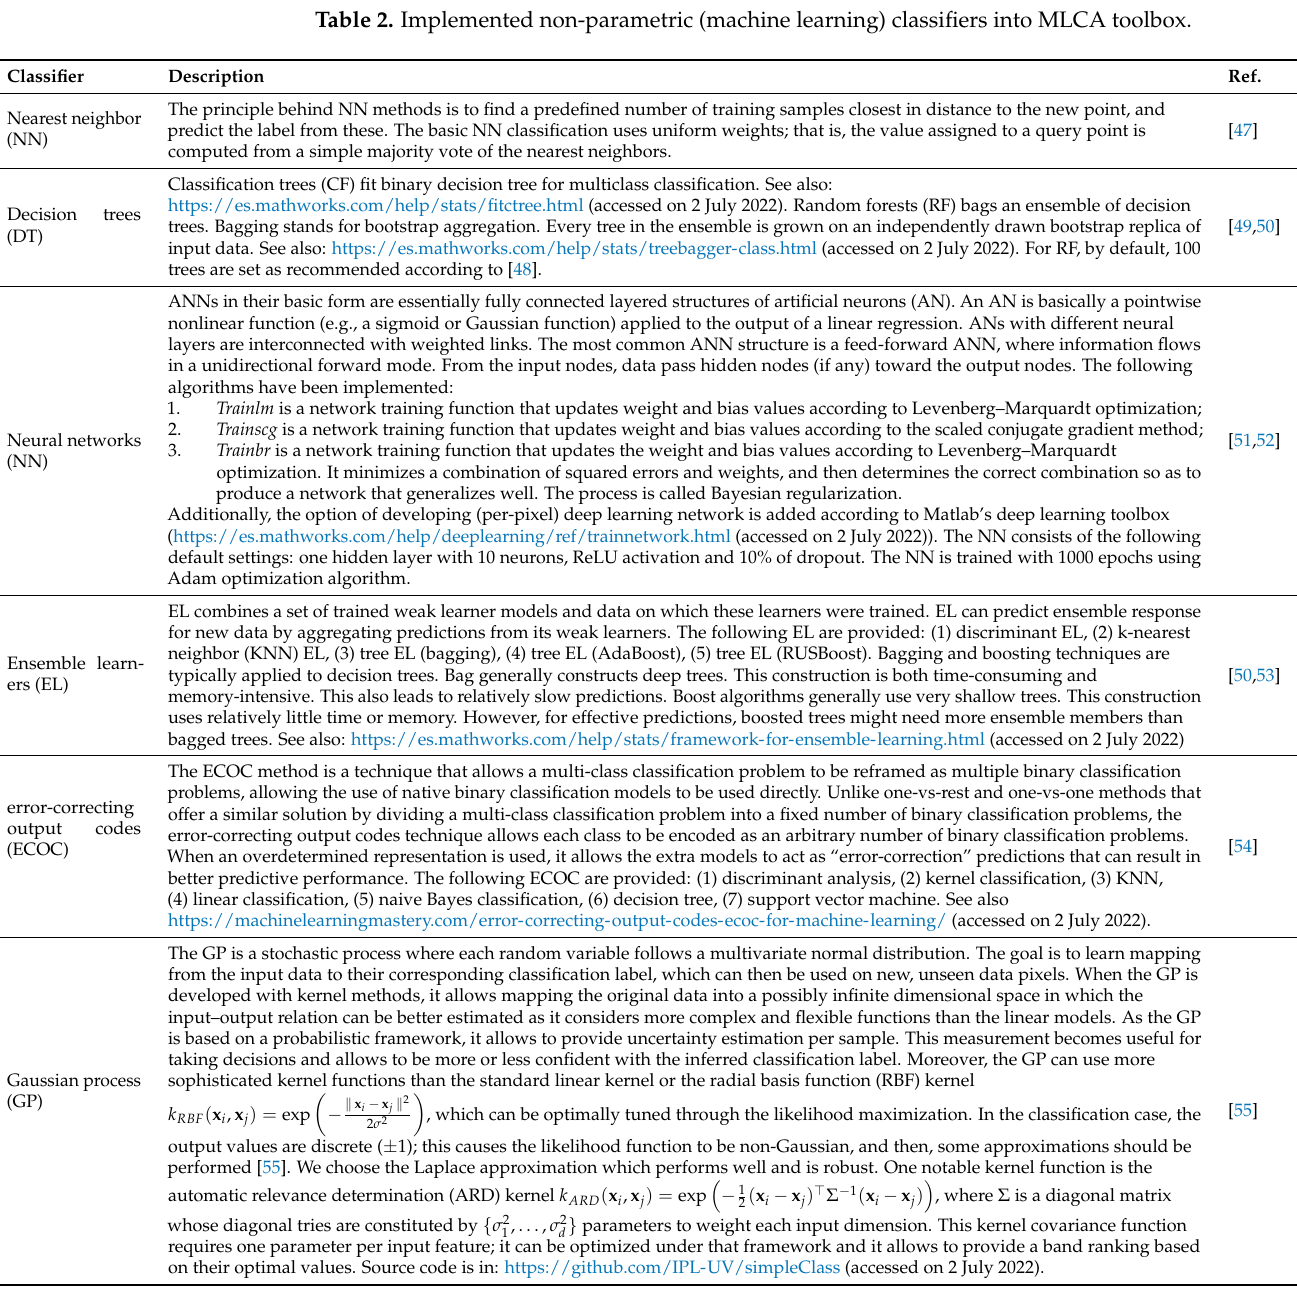
Table 2. Implemented non-parametric (machine learning) classifiers into MLCA